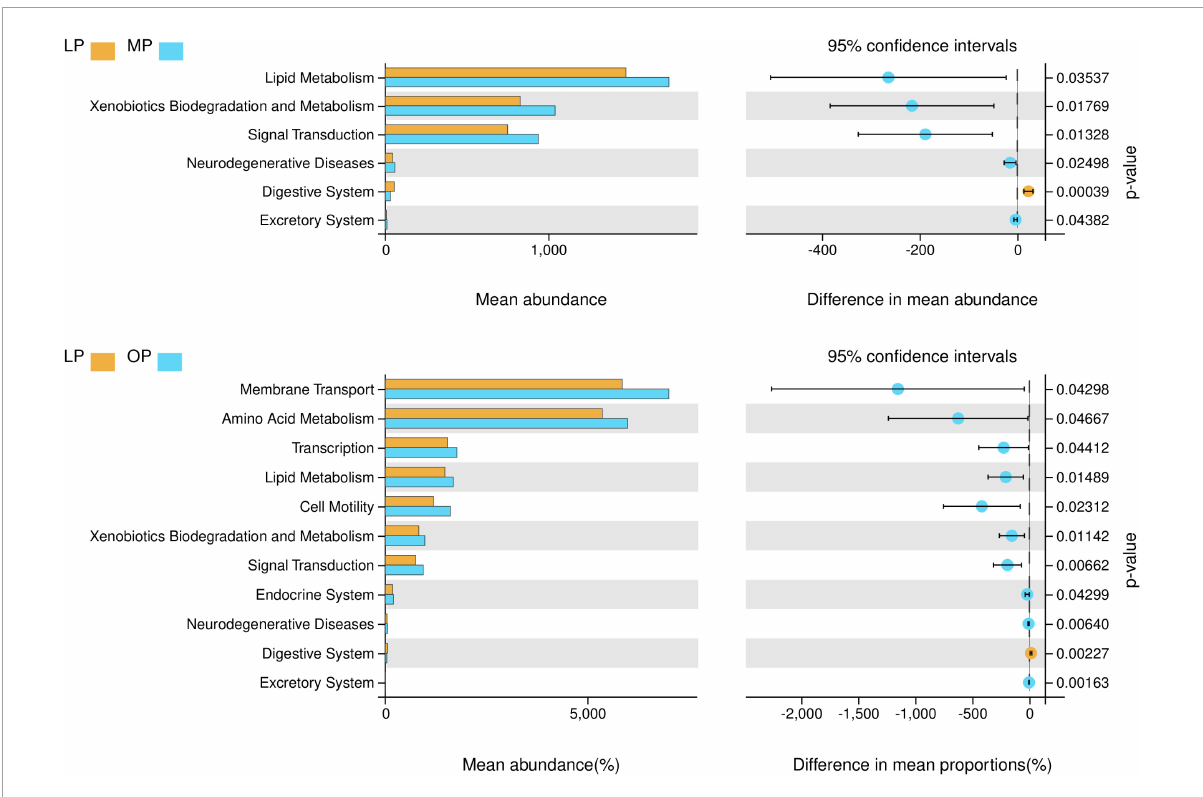
FIGURE5 Analysis of differential function at different stages of the menstrual cycle (level 2) ( P <